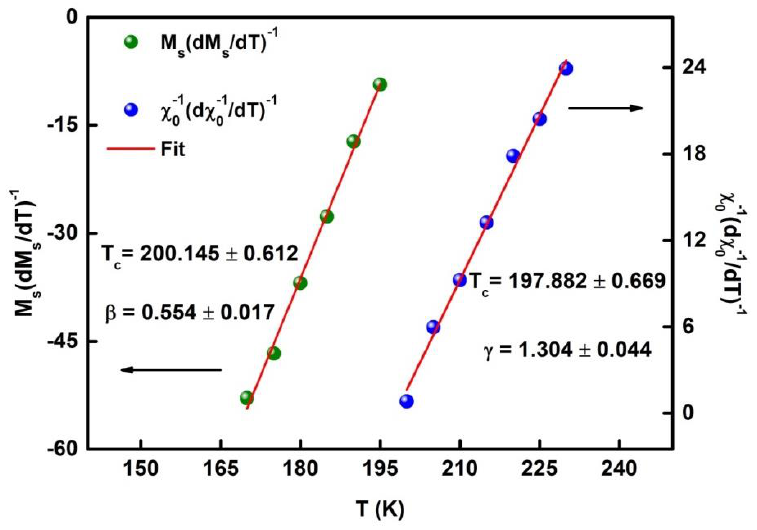
Magnetochemistry 2022 , 8 , 179 Figure 10. Kouvel – Fisher plots for the spontaneous magnetization and the inverse of initial sus- Figure 10. Kouvel–Fisher plots for the spontaneous magnetization and the inverse of initial susceptibility. ceptibility.